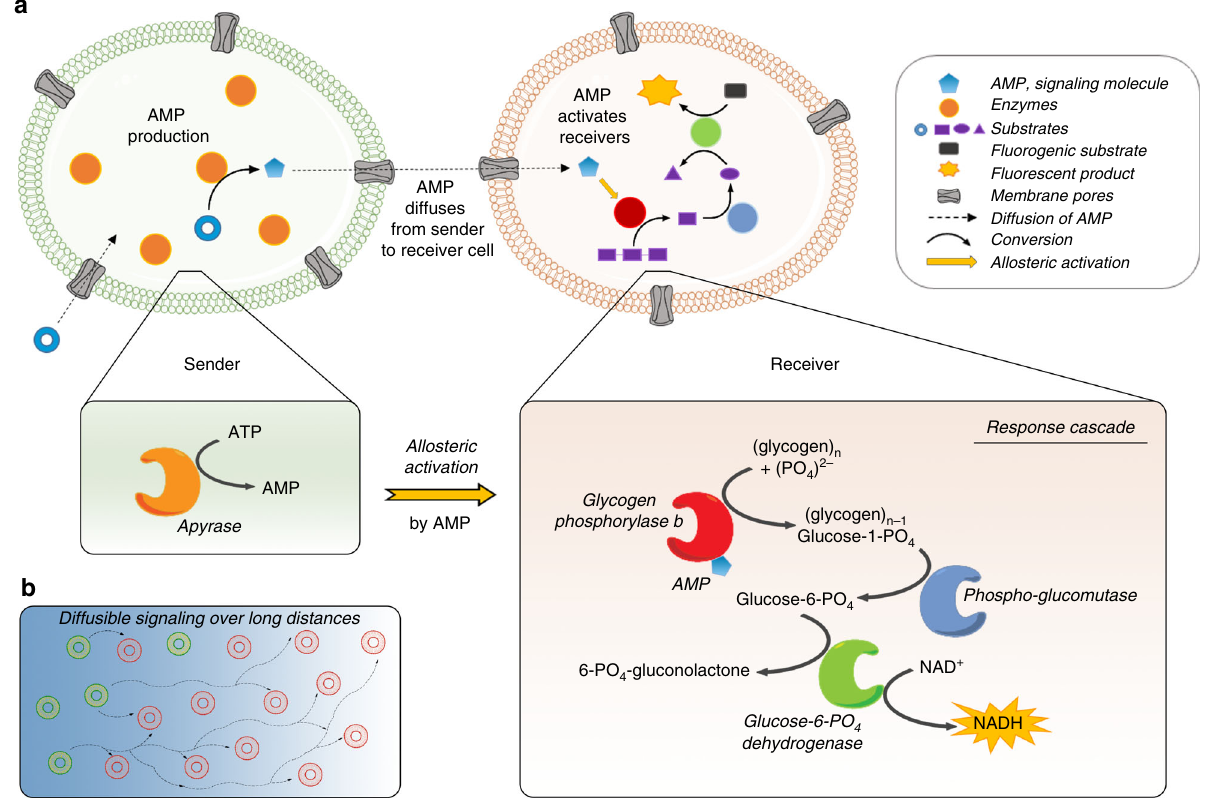
Fig. 1 Design of a communication pathway capable of signal ampli fi cation between two populations of arti fi cial cells. a A signalling molecule (AMP) is produced by the Sender population and diffuses to the Receiver population, where it is perceived, processed, and an internal response is generated. The Response Cascade encapsulated in the Receivers is capable of signal ampli fi cation by allosteric activation of the fi rst enzyme in a cascade that ultimately generates NADH, which is an important anabolic metabolite and here speci fi cally used as fl uorescent reporter of successful communication. b The signal ampli fi cation in the Receivers permits communication over long distances, despite strong dilution of the chemical signal in the external